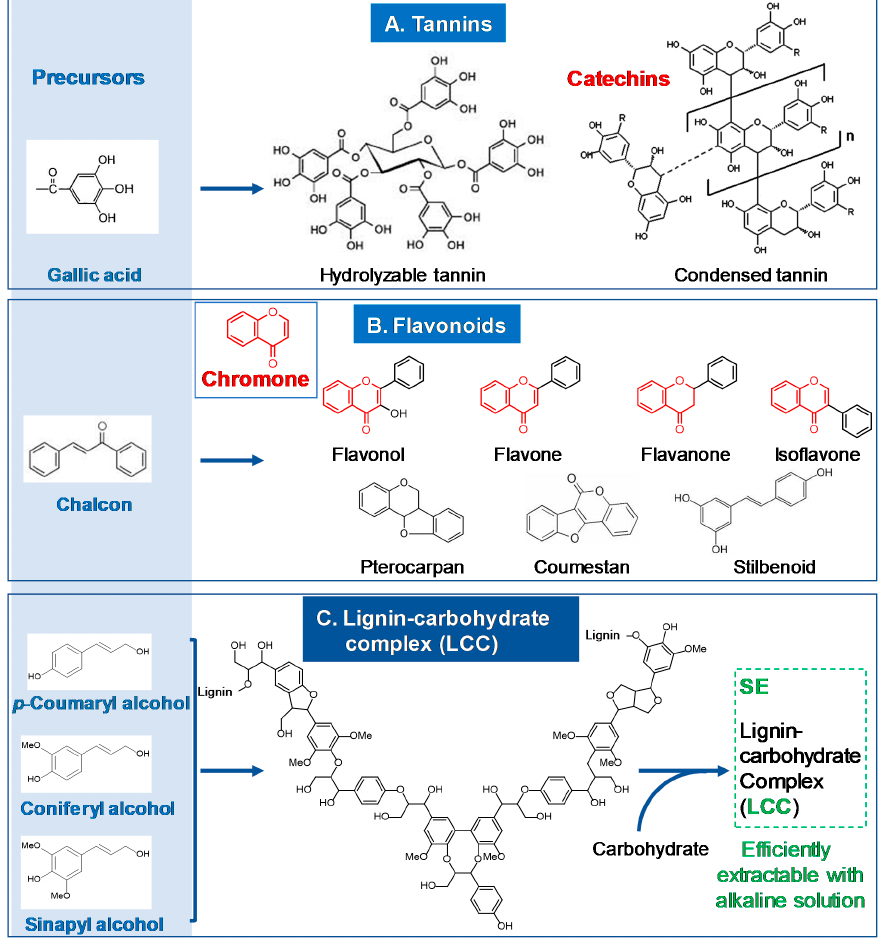
Figure 1. Three major polyphenols, that is tannins ( A ), flavonoids with or with backbone structure of chromone ( B ) and lignin-carbohydrate complex (LCC) ( C ), in the natural kingdom. Cited and modified from Reference [4] with permission.